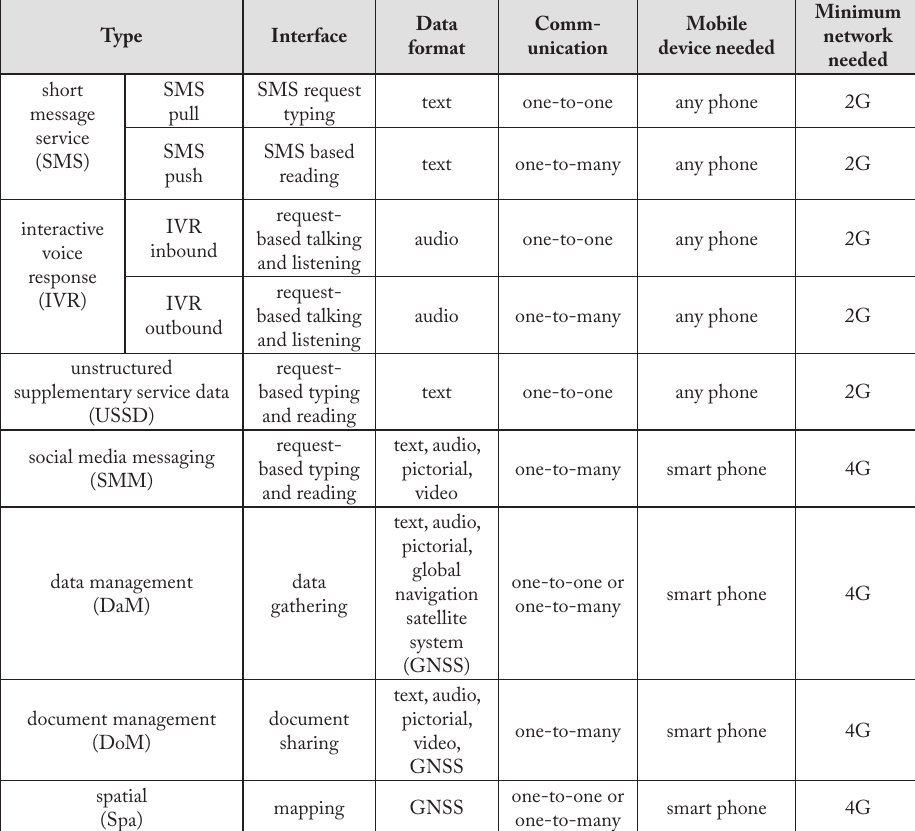
Table 2: Types of ICTs identified in Ghana’s agricultural system Type